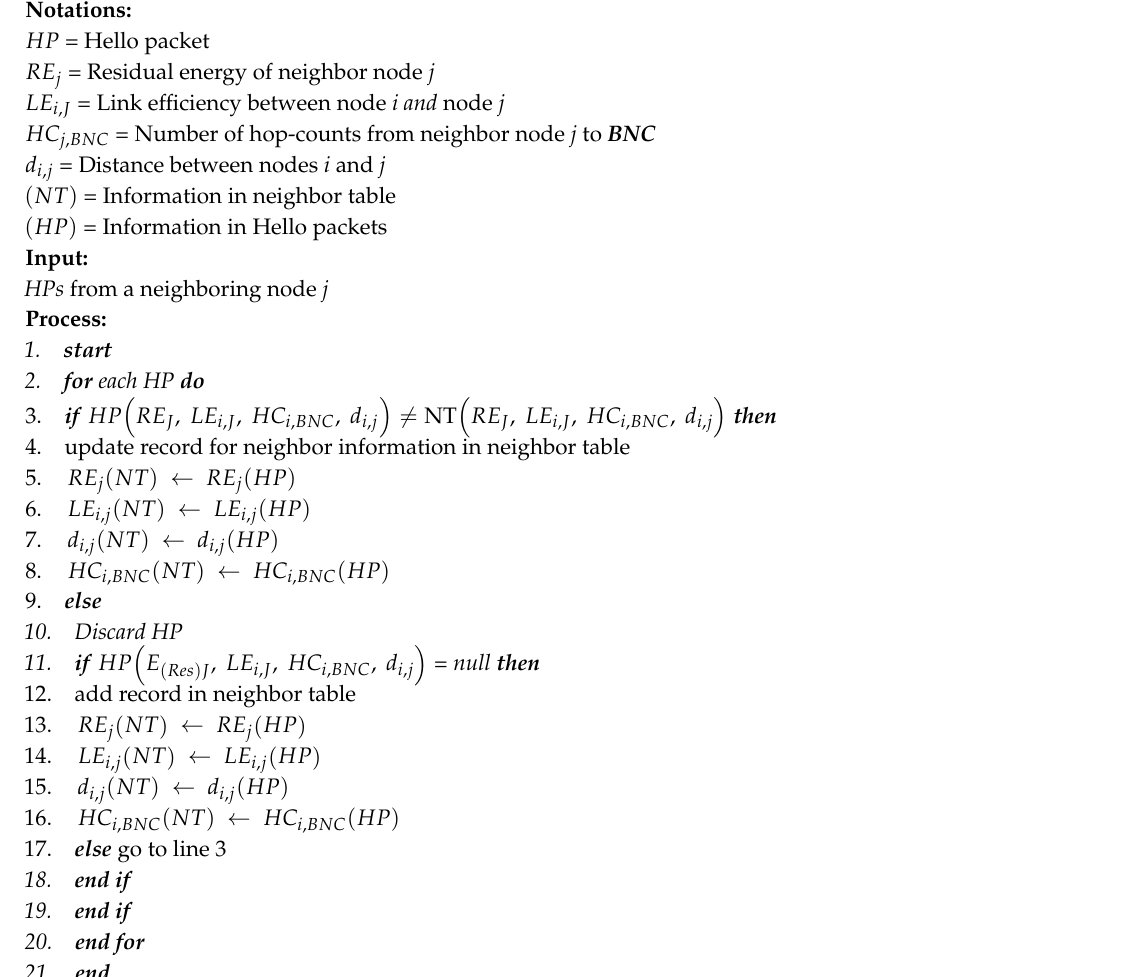
Algorithm 1 : Neighbor table construction algorithm of ELR-W protocol at node